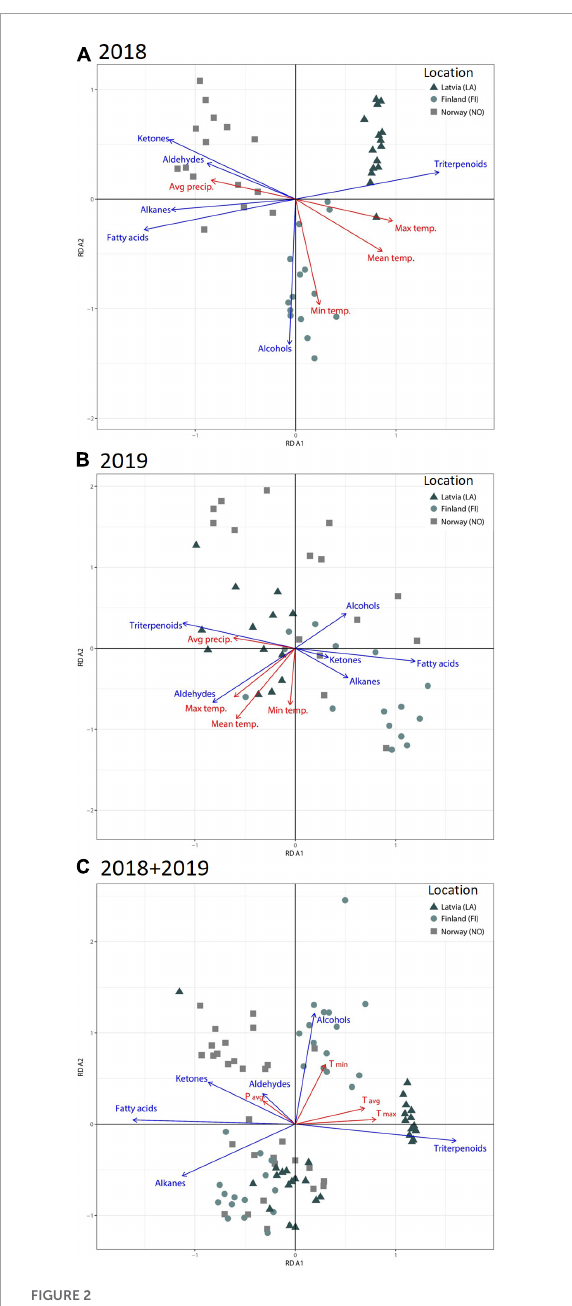
FIGURE2 RDA analysis presenting groups of compounds of berry wax and weather variables in different latitudinal locations in years (A) 2018, (B) 2019, and (C) combined data from 2018 and